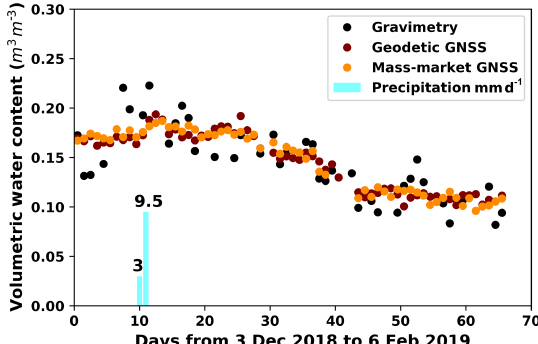
Figure 12. GLONASS comparison of daily soil moisture. The re- sults of the geodetic and mass-market antennas are compared with the reference gravimetric data set.